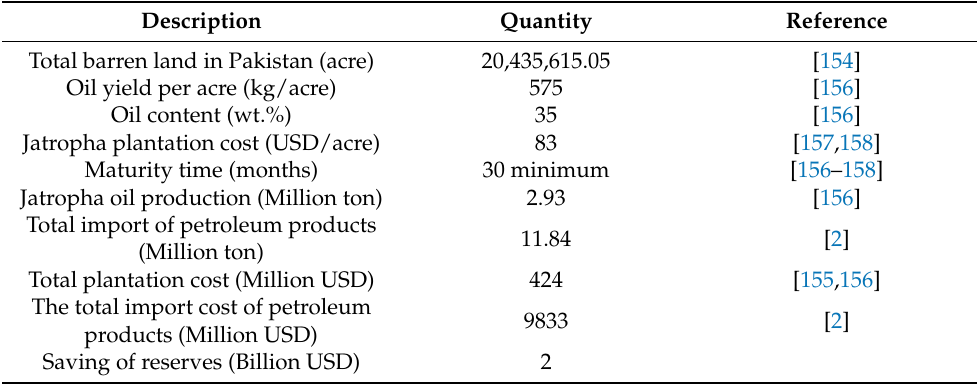
Table 10. The potential of Jatropha Curcas